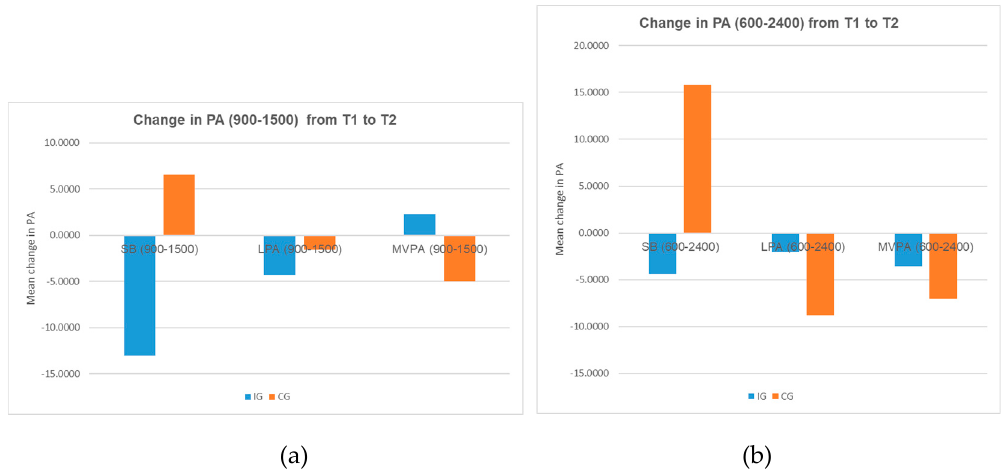
Figure 4. ( a ) Change in physical activity during school hours over time. ( b ) Change in physical activity Figure 4. (a) Change in physical activity during school hours over time. (b) Change in physical activity during waking hours over time. during waking hours over time.